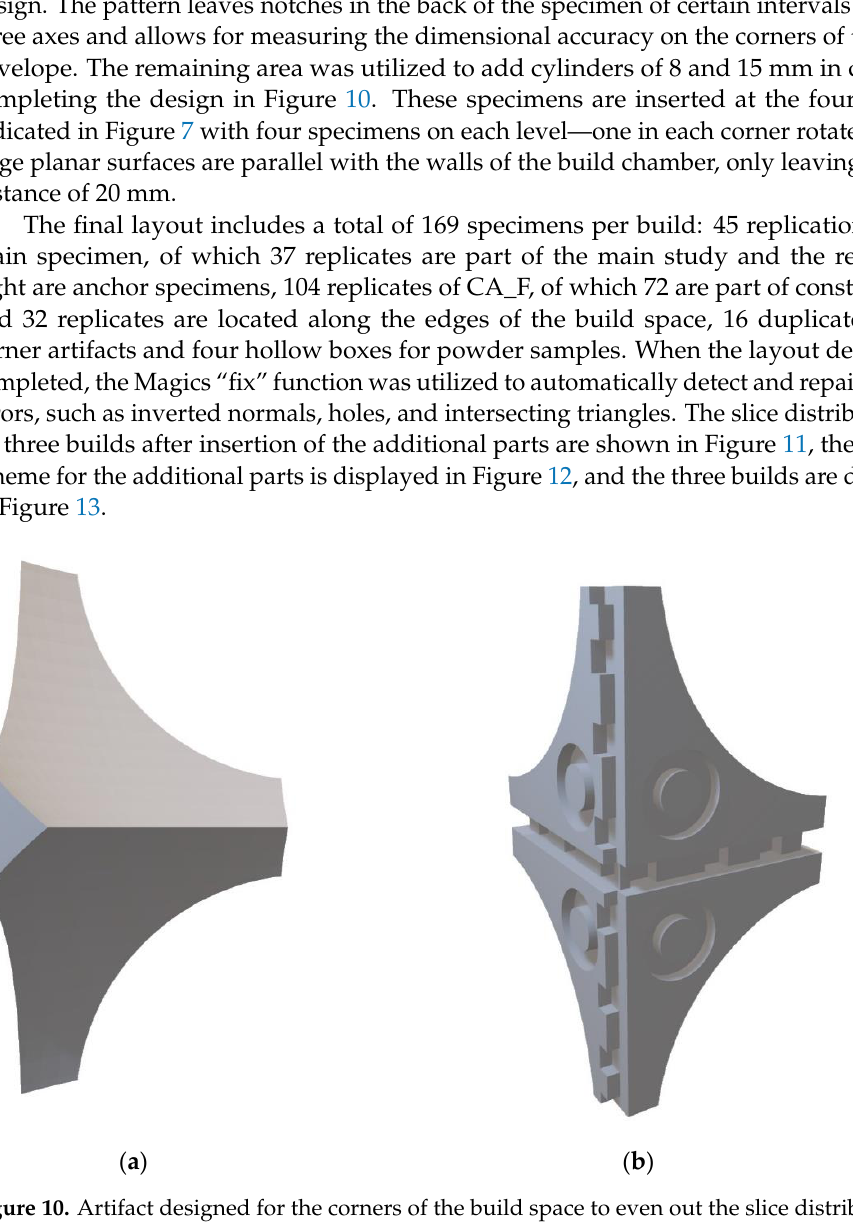
Figure 9. Locations for powder sample boxes. Roman numerals (I – IV) indicate the positions of specimens 150 – 153. ( a ) Front view; ( b ) top view showing the labeling of the boxes.